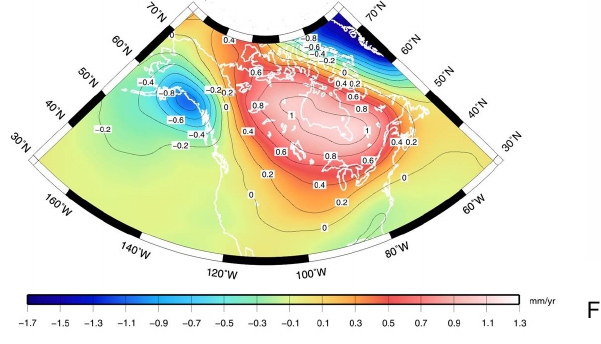
Figure 3. Time evolution of the first two GLDAS modes of variabil- ity. The second plot shows a long-term hydrology varia- tion, where the computed trend of the principal component is 0.1 yr − 1